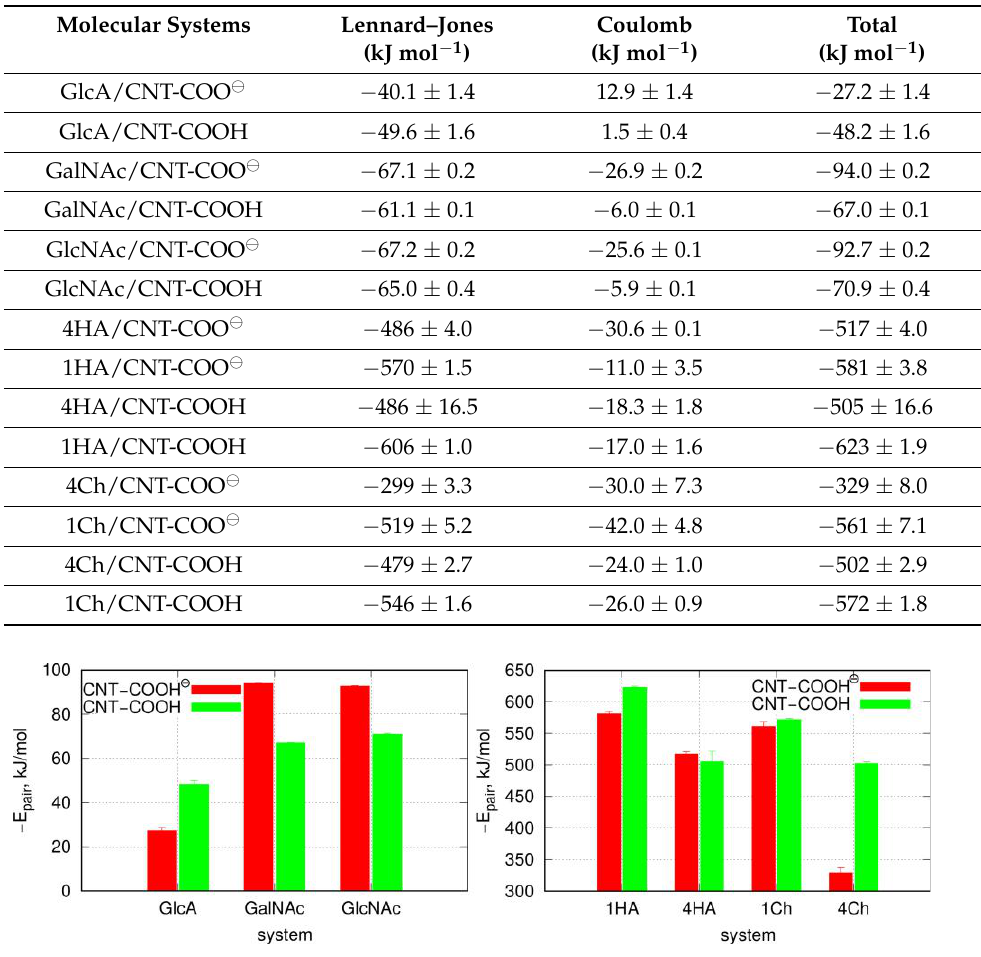
Figure 3. Total mean-pair-interaction energies from Table 1 plotted as bar charts. The left panel stands for the GlcA, GalNAc and GlcNAc monosaccharides, while the right panel stands for HA and Ch oligosaccharides with a single (1HA and 1Ch) and four (4HA and 4Ch) carbohydrates on the fCNT surface.